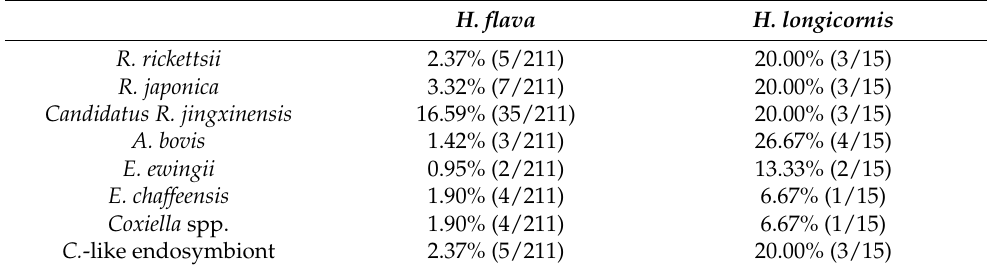
Table 2. Prevalence of Rickettsia , Anaplasma , Ehrlichia and Coxiella in H. flava and H. longicornis